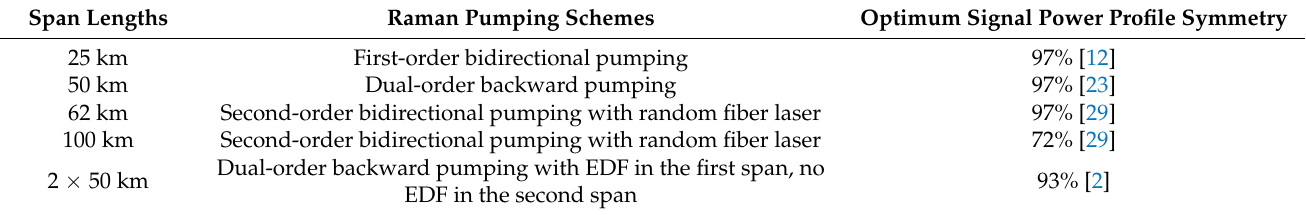
Table 1. Summary of the best span symmetry with corresponding Raman schemes at different span